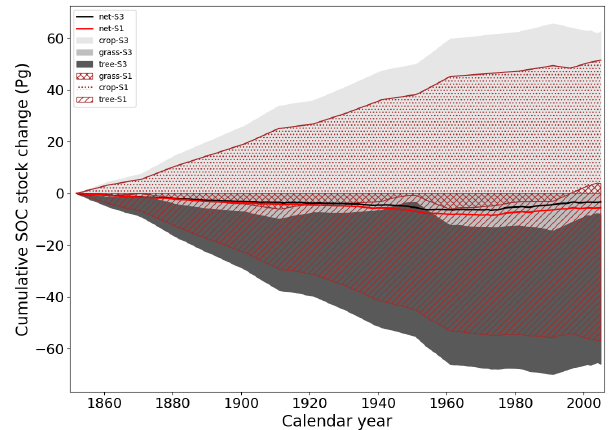
Figure 7. Cumulative SOC stock changes per PFT during 1850– 2005 implied by variable land cover, climate, and CO 2 , without erosion (grey colors) and with erosion (red colors).